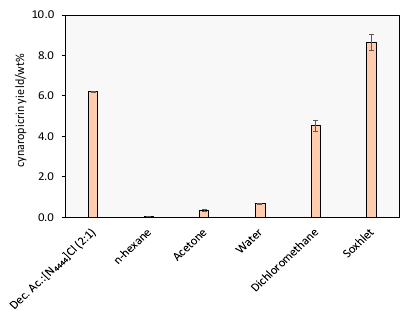
Figure 4. Cynaropicrin extraction yields from C. cardunculus leaves with the solution composed of 70% of water in DES and several molecular solvents at fixed conditions: T = 25 °C, t = 60 min, a S/L ratio = 1:30. The results presented correspond to the average of three independent experiments.